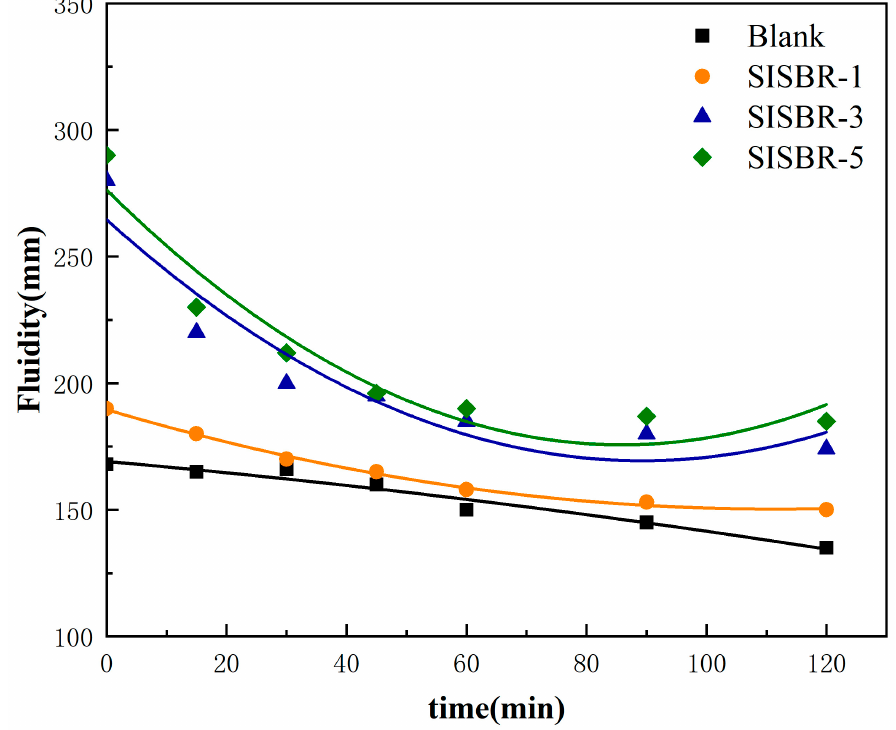
Figure 6. Fluidity behavior of the cement pastes with SISBR latex.